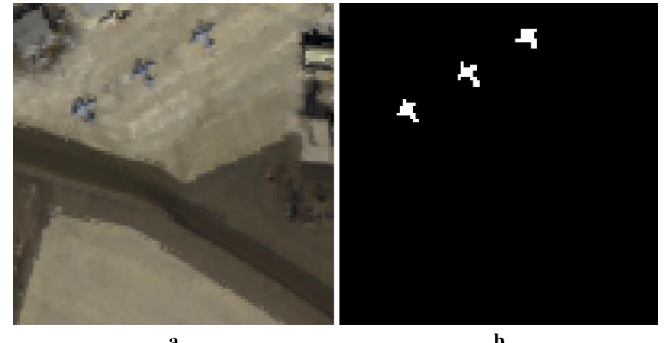
Figure 2. First real-world data set: AVIRIS San Diego airport scene. ( a ) False color image; ( b ) ground-truth map.